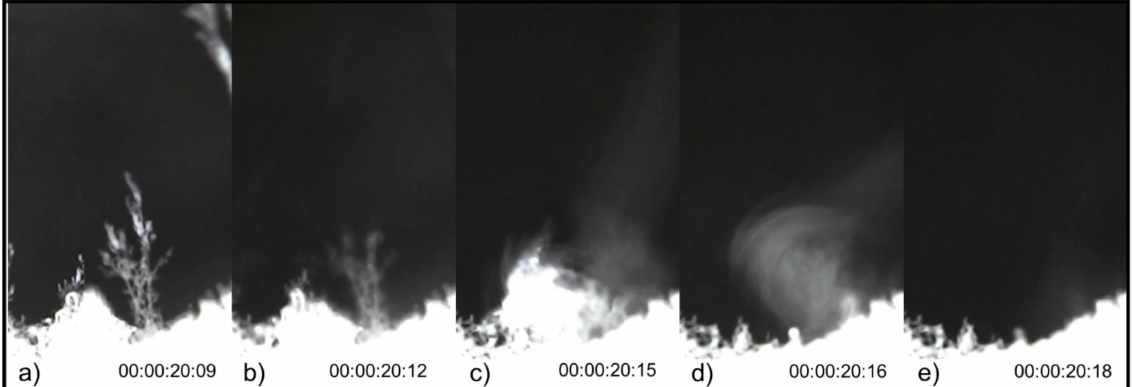
Figure 11. From left to right: frames ( a ) 20 s 09, ( b ) 20 s 12, ( c ) 20 s 15, ( d ) 20 s 16, ( e ) 20 s 18, showing the successive removal of dendrites and packed ice that are seen in ( a ) but not in ( e